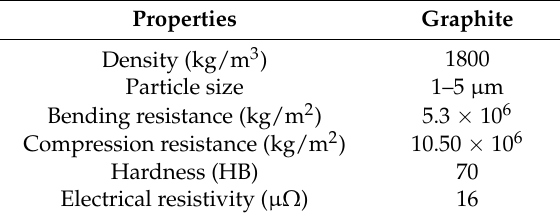
Table 3. Properties of selected graphite electrodes (courtesy of matweb ©).